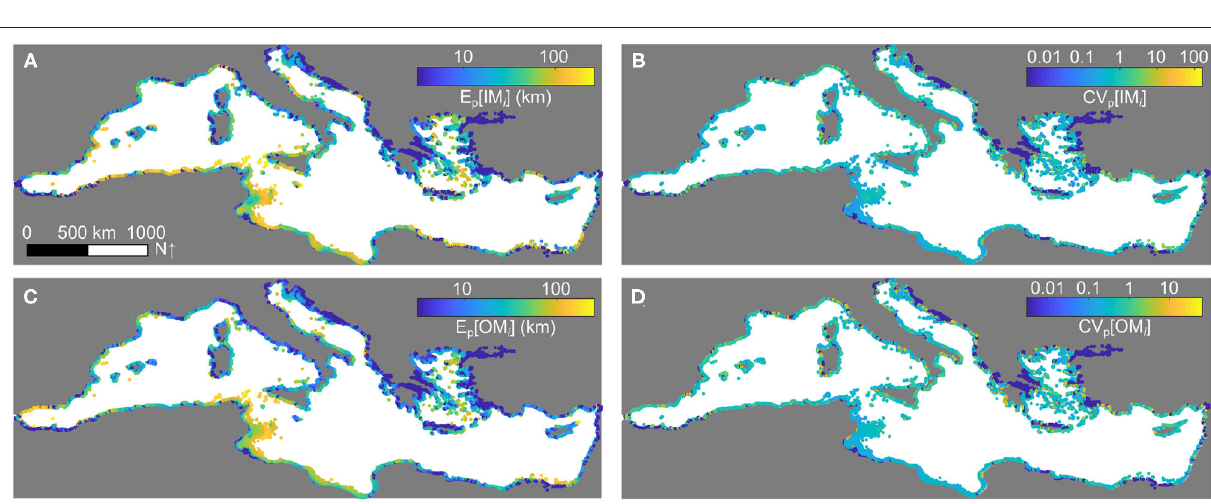
while hotspots located along the African coastline may be area ( Figure 6B